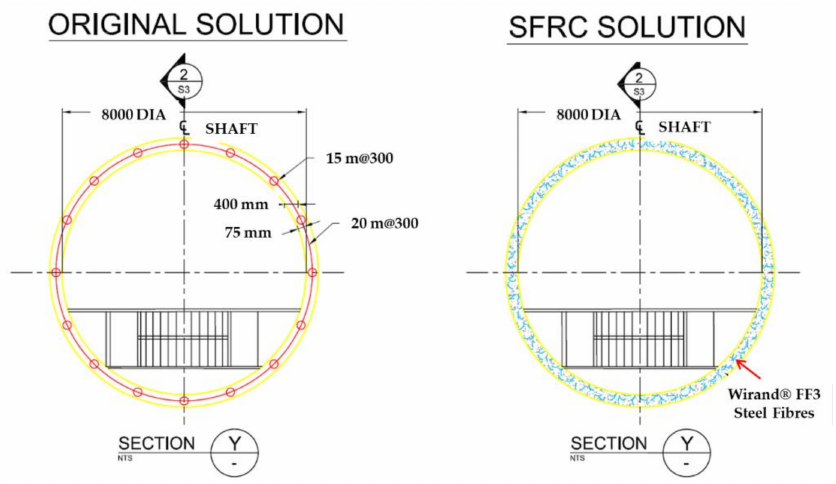
Figure 5. Final proposed SFRC solution for shaft